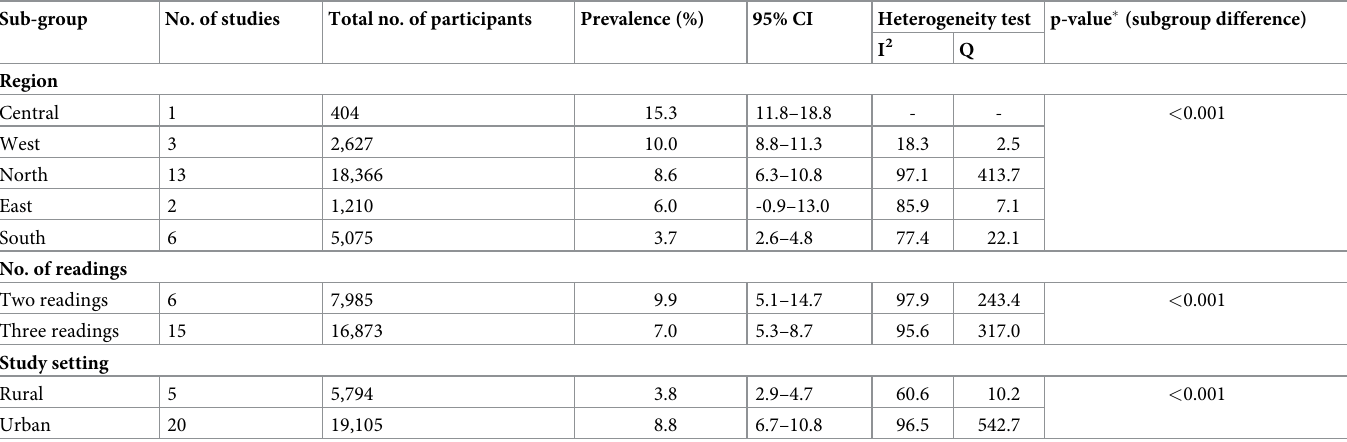
Table 2. Prevalence of hypertension among adolescents by